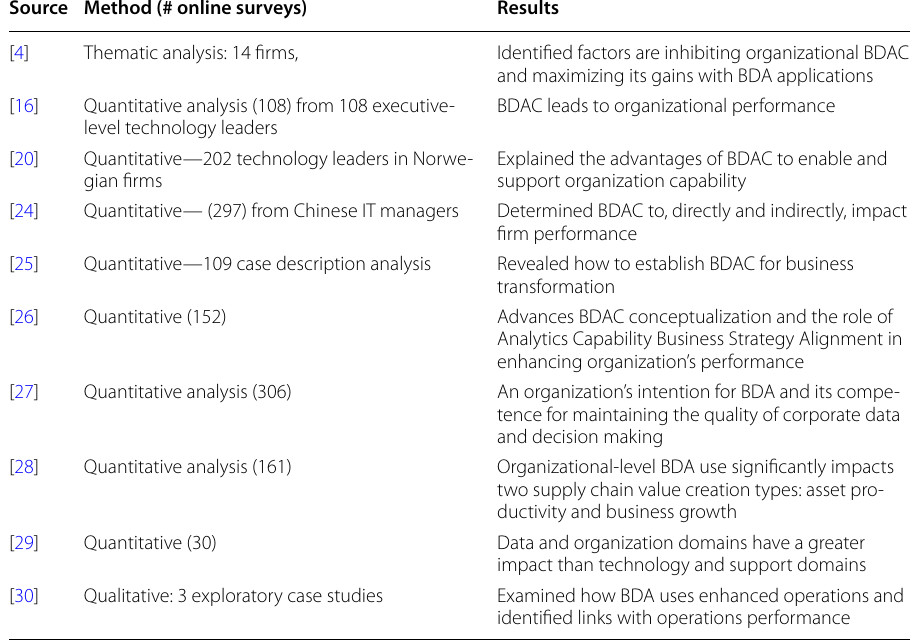
Table 2 Examples of BDAC review studies Source Method (# online surveys)